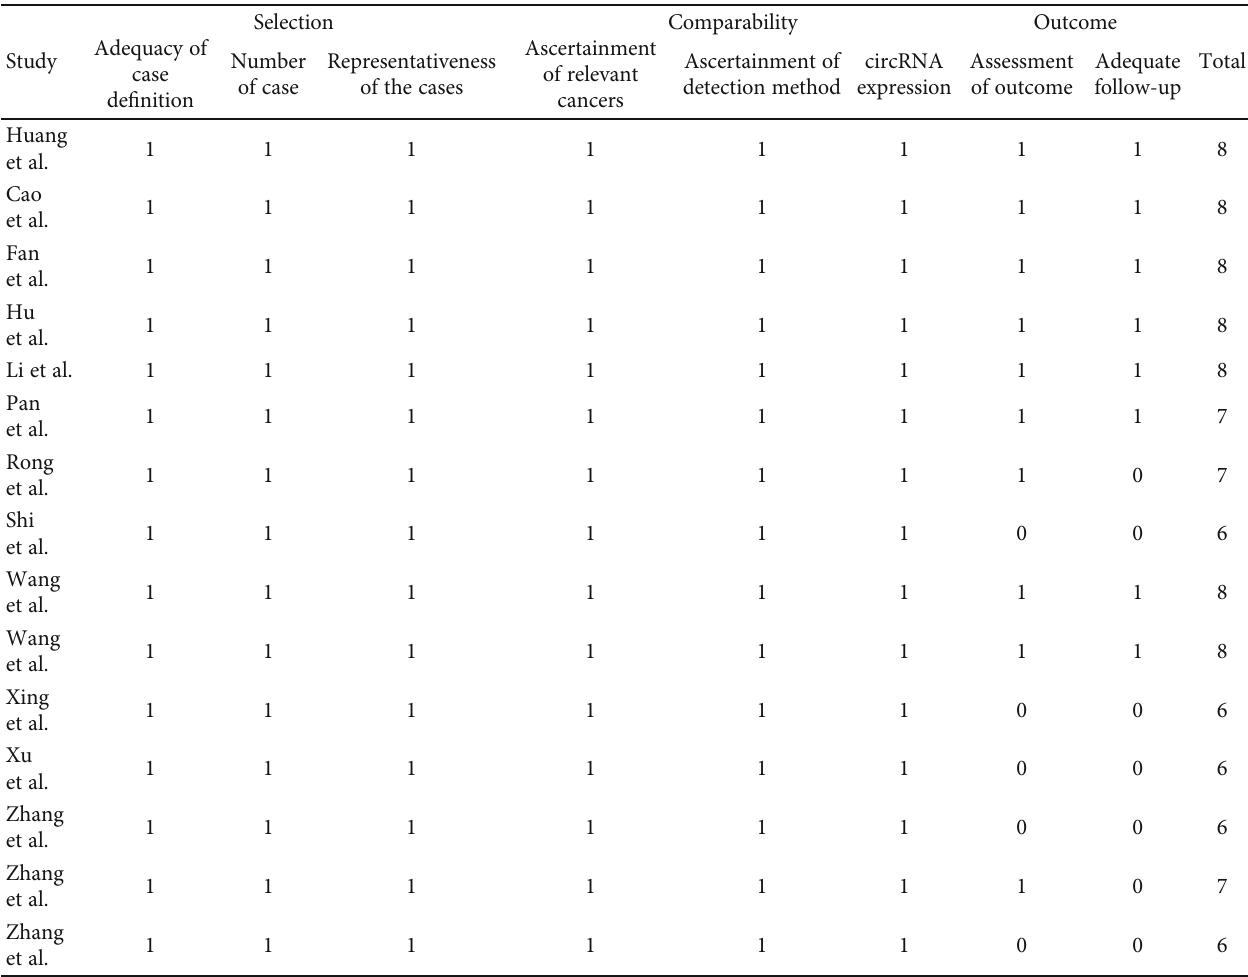
Table 3: Quality assessment of eligible studies (Newcastle-Ottawa